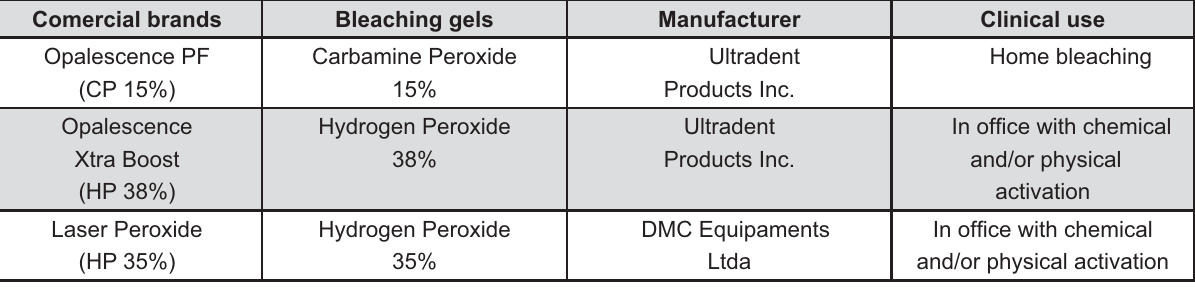
Figure 1- Bleaching gels used A